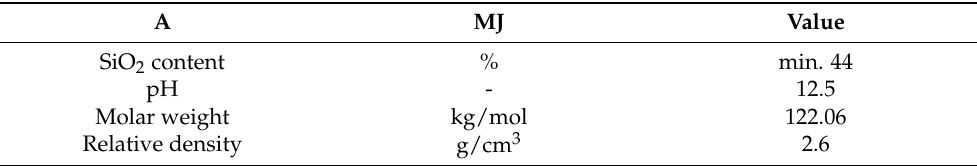
Table 3. Composition of anhydrous disodium metasilicate.